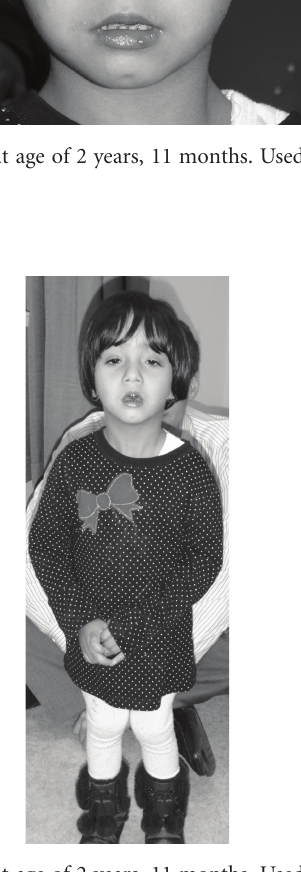
Figure 2: Patient at age of 2 years, 11 months. Used with permis- sion.